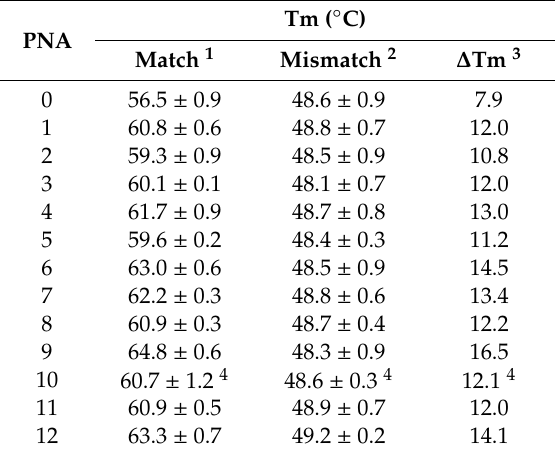
Table 2. Thermal stability of PNA/DNA and tolane-PNA/DNA duplexes.